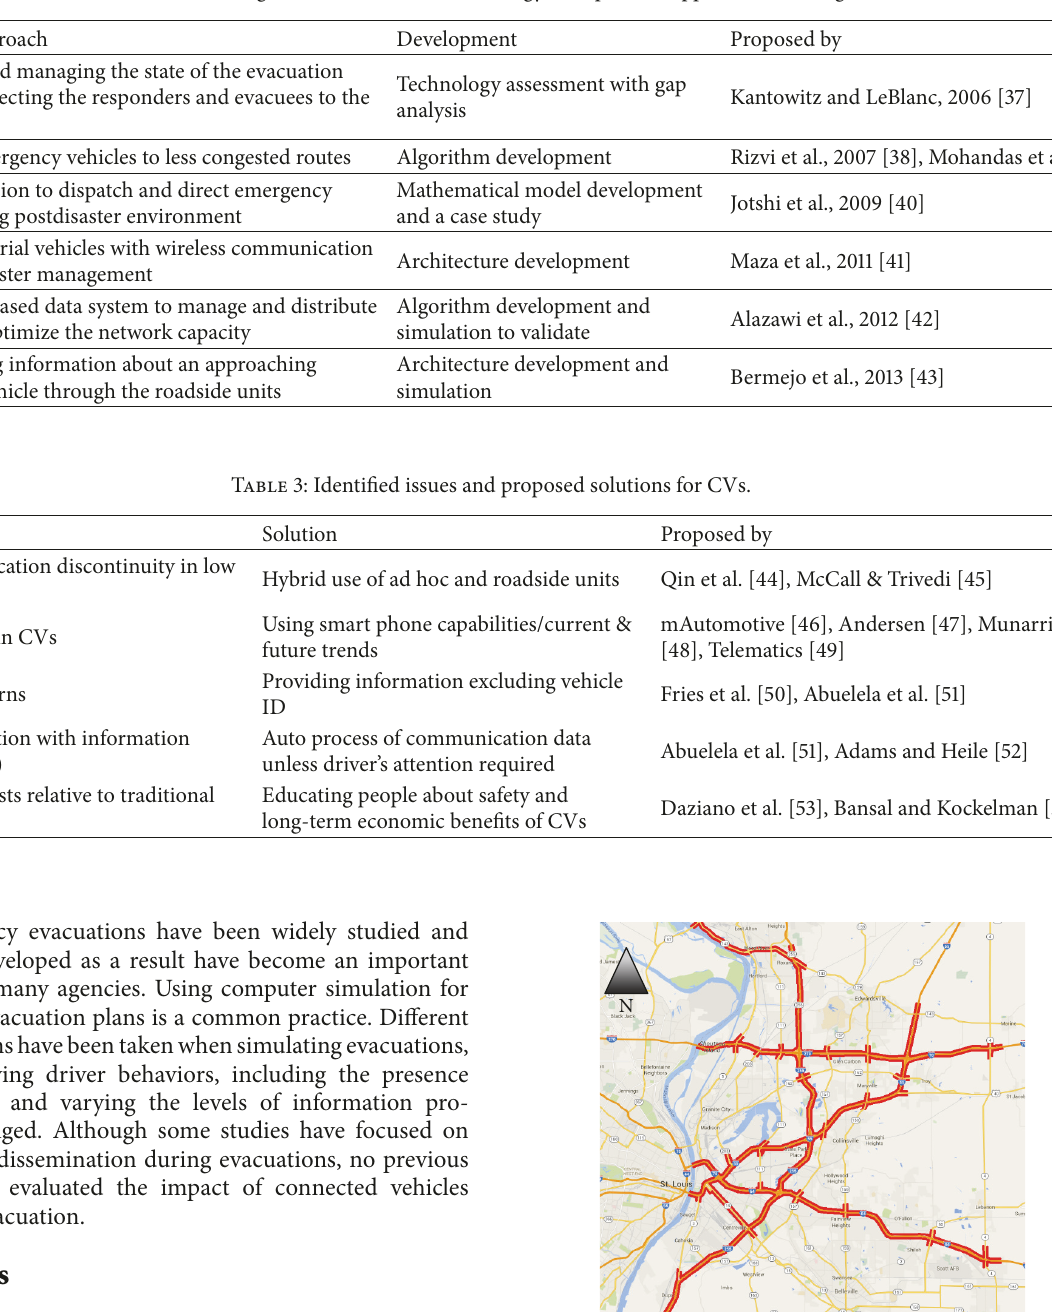
Table 2: Review of existing connected vehicles technology with possible applications during evacuations.